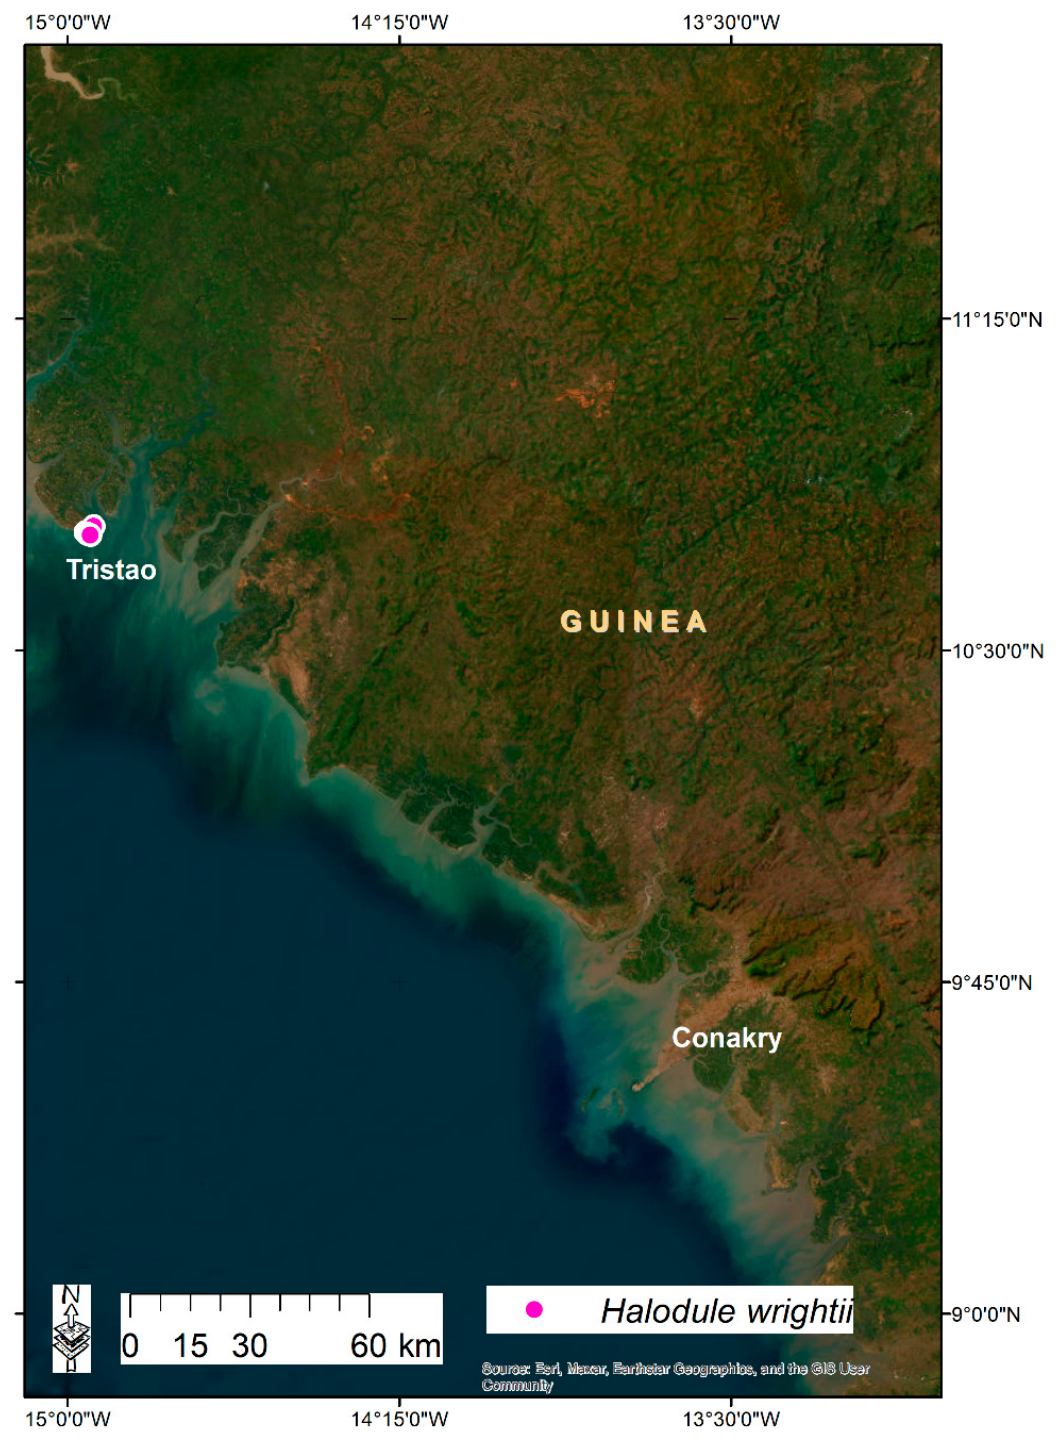
Figure 7. Seagrass distribution in Guinea.